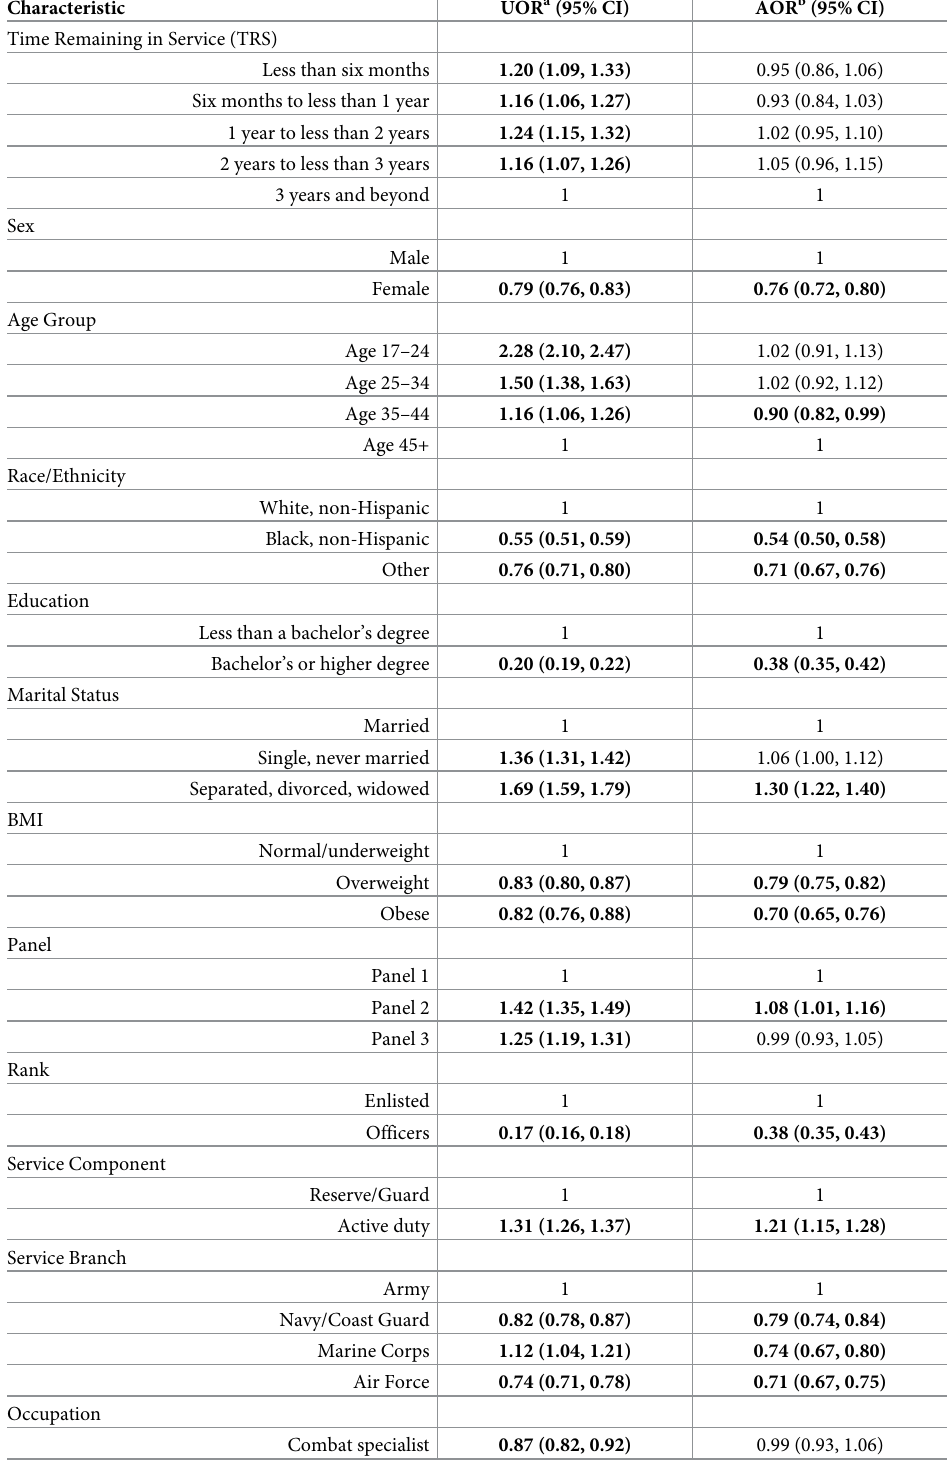
Table 2. Unadjusted and adjusted odds of baseline smoking among study participants (N = 67,029), in the Millen- nium Cohort